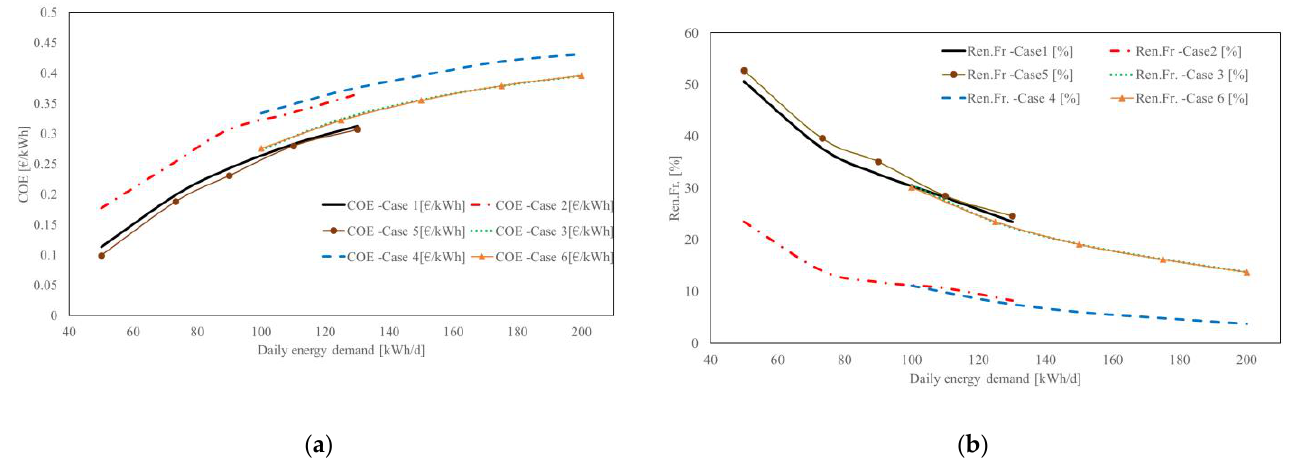
Figure 5. Wind potential parametric study. ( a ) COE vs. wind potential; ( b ) Ren.Fr. vs. wind potential.